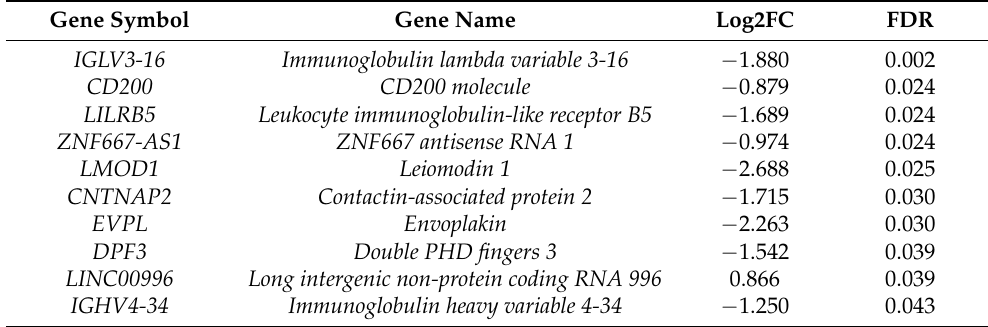
Table 5. Gene-expression differences between experienced breacher vs unexposed control. Gene